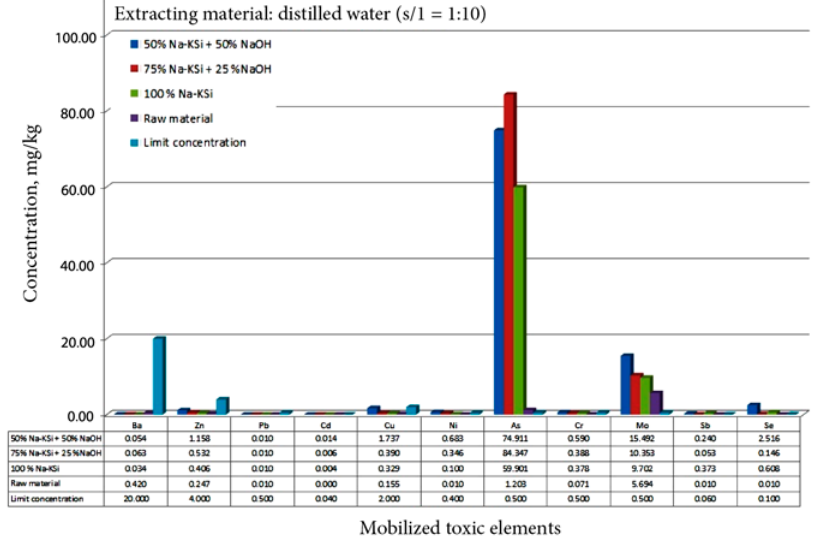
Fig. 13. Quantity of mobilized toxic elements from 120 days age geopolymers using distilled water as extracting material (solid/liquid ratio